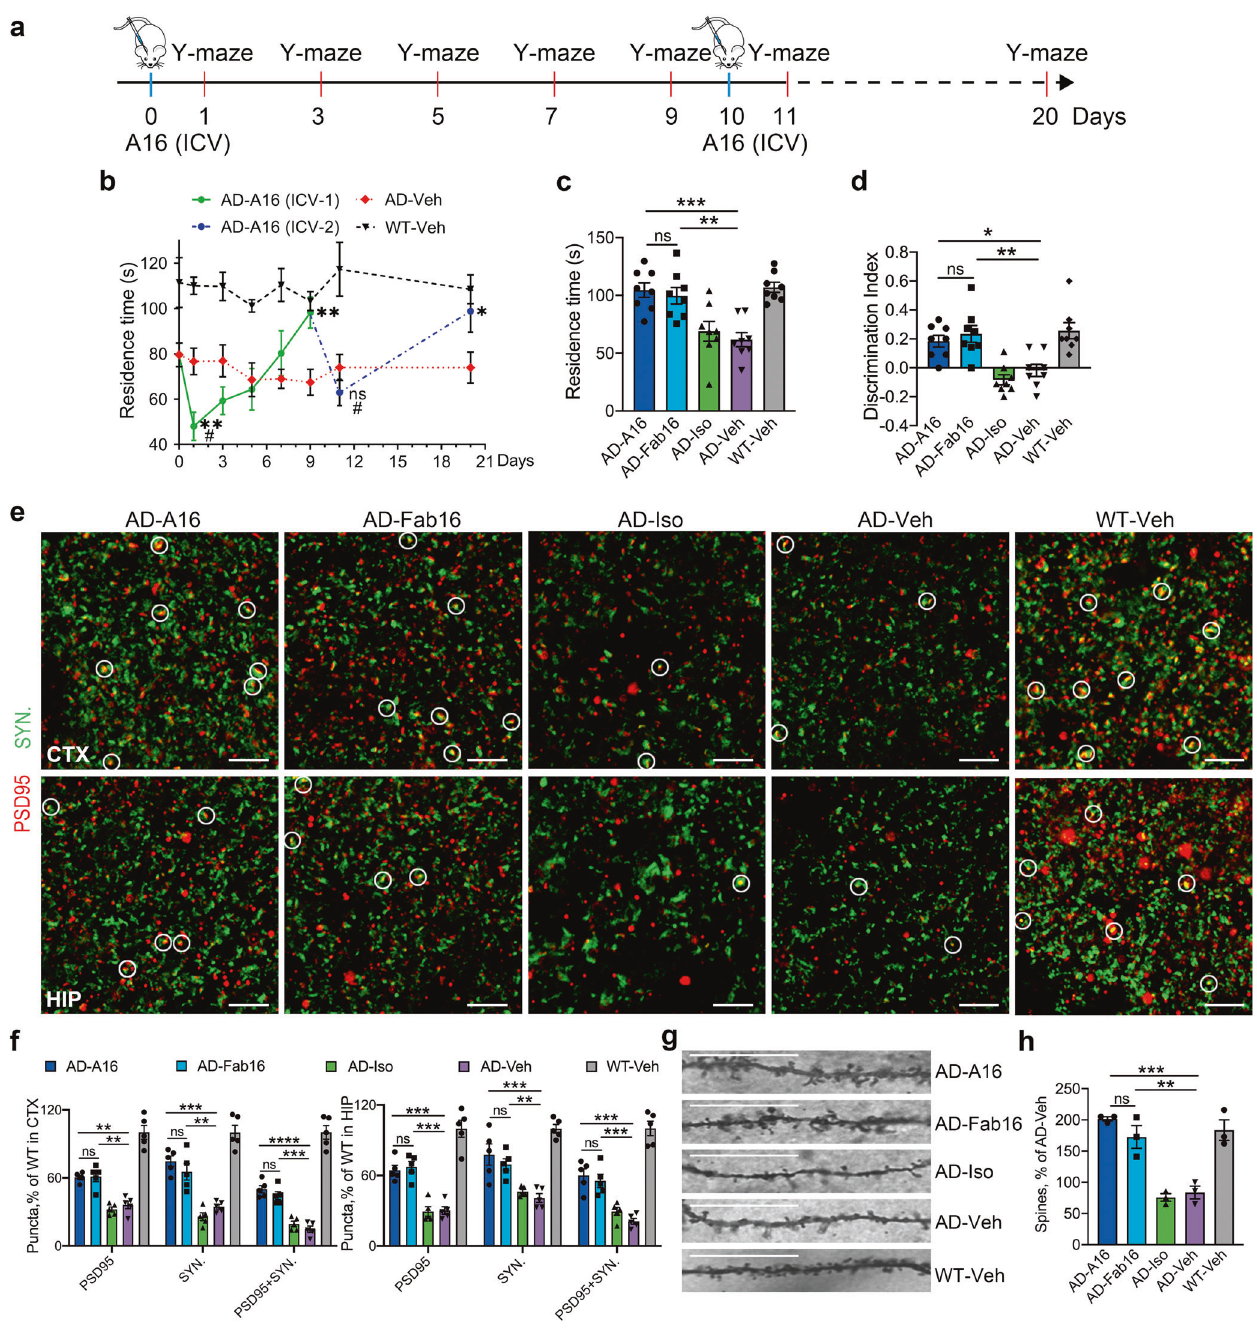
Fig. 5 Full effector antibody A16 rescues memory de fi cits and synapse loss in APP/PS1 mice at 2-week post 2nd antibody treatment. a Schematic representation of treatment regimen with A16 and experimental design. b APP/PS1 mice were administered A16 or vehicle on Days 0 and 10, and underwent Y-maze test on days 1, 3, 5, 7, 9, 11, and 20. The time spent in the novel arm was scored. n = 8 mice, AD-A16 versus AD-Veh: Day 1, ** P = 0.0052; Day 9, ** P = 0.0049; Day 11, ns, P = 0.1958; Day 20, * P = 0.0470; A16 at Day 0 versus A16 at Day 1, # P = 0.0112; A16 at Day 9 versus A16 at Day 11, # P = 0.0109. c APP/PS1 or WT mice were treated with A16, Fab16, isotype control antibody, or PBS twice biweekly, and their cognitive performance was evaluated using Y-maze test at 2-week post 2nd antibody treatment. The time spent in the novel arm of Y-maze was scored ( n = 8 mice). d Discrimination index of the mice in novel object recognition test ( n = 8 mice). e Immunolabeling of colocalized PSD95 (red) and synaptophysin (green) puncta in the cortex and hippocampus of APP/PS1 or WT mice treated with A16, Fab16, isotype control antibody, or PBS, at 2-week post 2nd antibody treatment. White circles indicate the colocalized PSD95 with synaptophysin puncta. Scale bar, 2.5 μ m. f Quanti fi cation of synaptic puncta or their apposition in e ( n = 5 mice). g Representative images of Golgi-stained dendrites from the cortex neurons of APP/PS1 or WT mice treated with A16, Fab16, isotype control antibody, or PBS, at 2-week post 2nd antibody treatment. Scale bar, 50 μ m. h Quanti fi cation of dendritic spine density in g ( n = 3 mice). Data are expressed as mean ± s.e.m. and were analyzed by one-way ANOVA with Tukey ’ s test ( c and d , f , h ) or student t-test ( b ). * P < 0.05, ** P < 0.01, *** P < 0.001, **** P < 0.0001; ns not signi fi cant